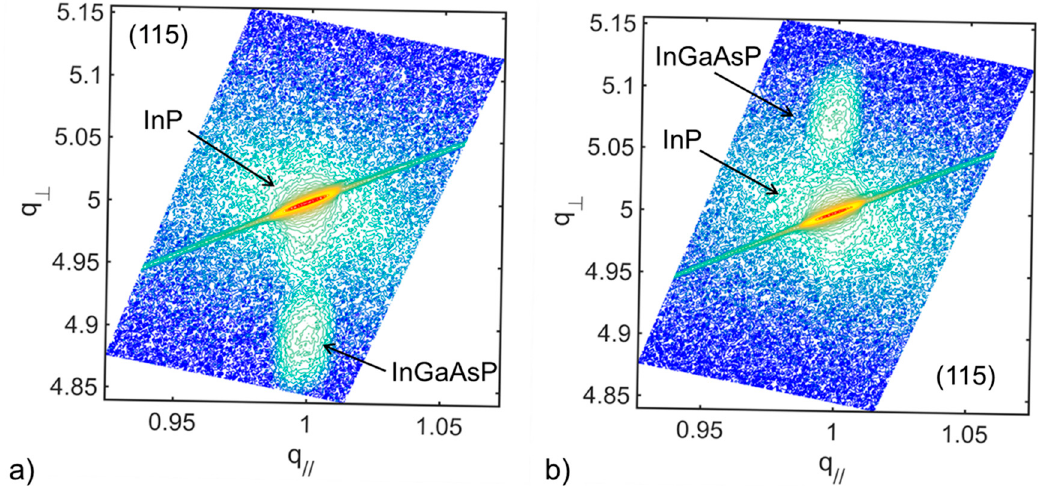
Figure 4 . ( a ) ω -2 θ scan and ( b ) AFM scan of the final epitaxial structure.